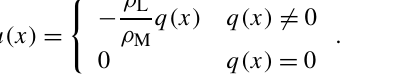
Figure 3. The two types of flexure model derived from Eq. (2). (a) The “fixed topography” situation in which subsidence matches the prescribed topographic profile (associated with load density). Load thickness is then equal to topography Topo (x) minus subsi- dence u(x) . (b) The fixed load case, equivalent to arbitrary forces. Any “load” may be applied, generating subsidence. Calculating in- fill of basins generated, should there be any, requires an iterative procedure since the amount of accommodation space must first be calculated explicitly and subsequently filled, hence creating more accommodation